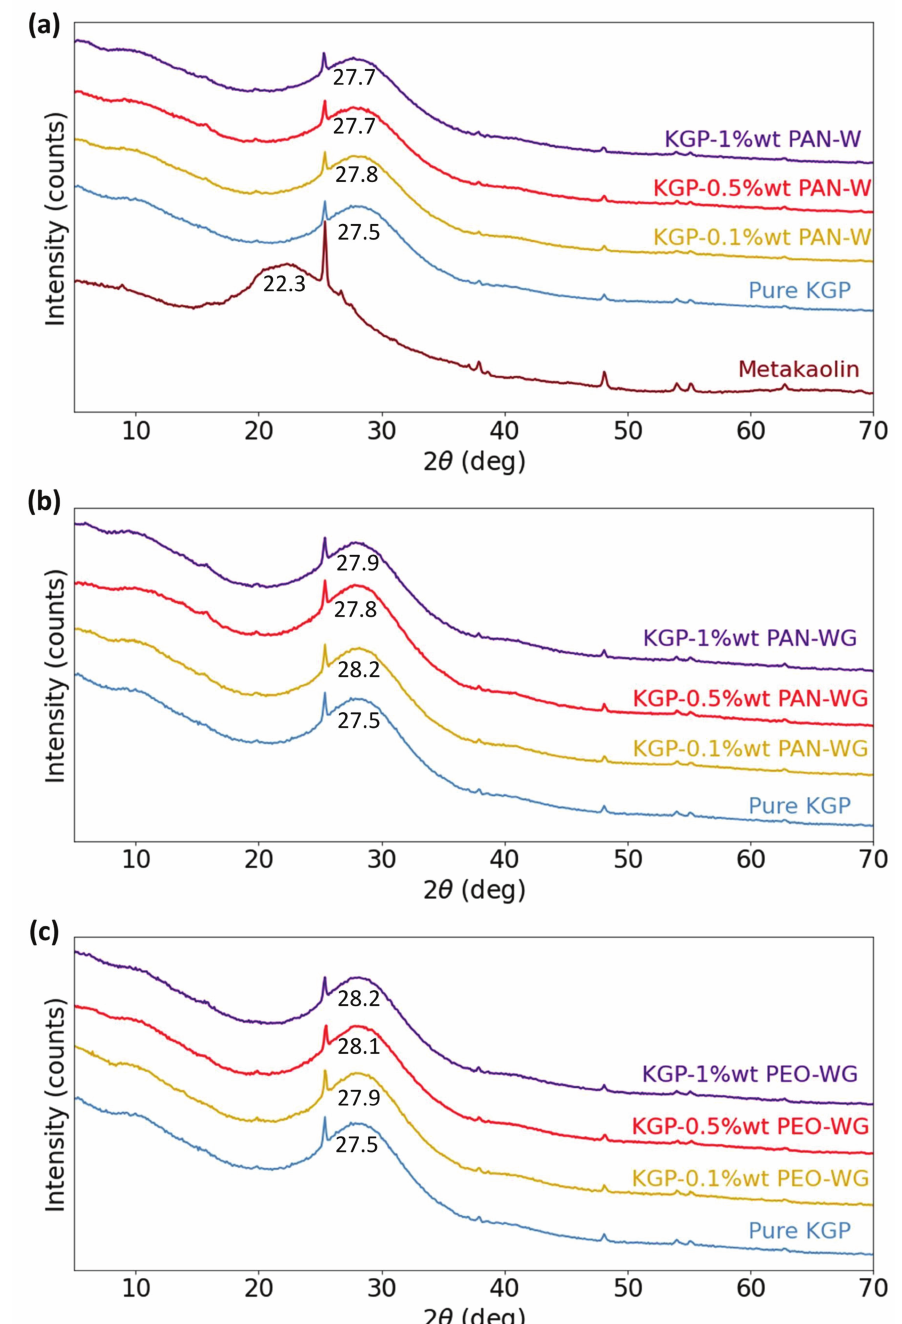
Figure 5. XRD patterns of Metakaolin, KGP and electrospun fiber-reinforced KGP